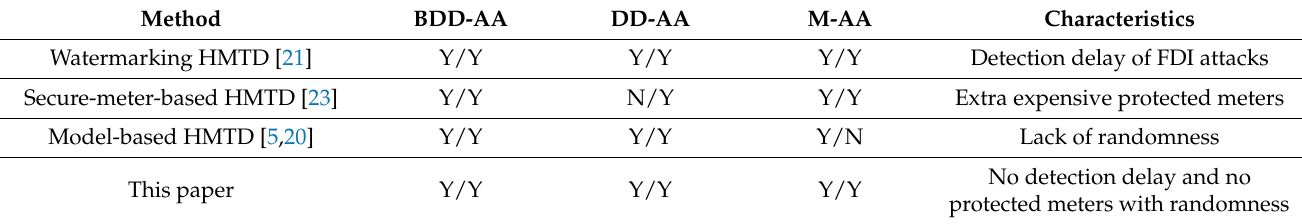
Table 1. Comparison of the proposed and existing HMTD methods regarding the hiddenness and detection